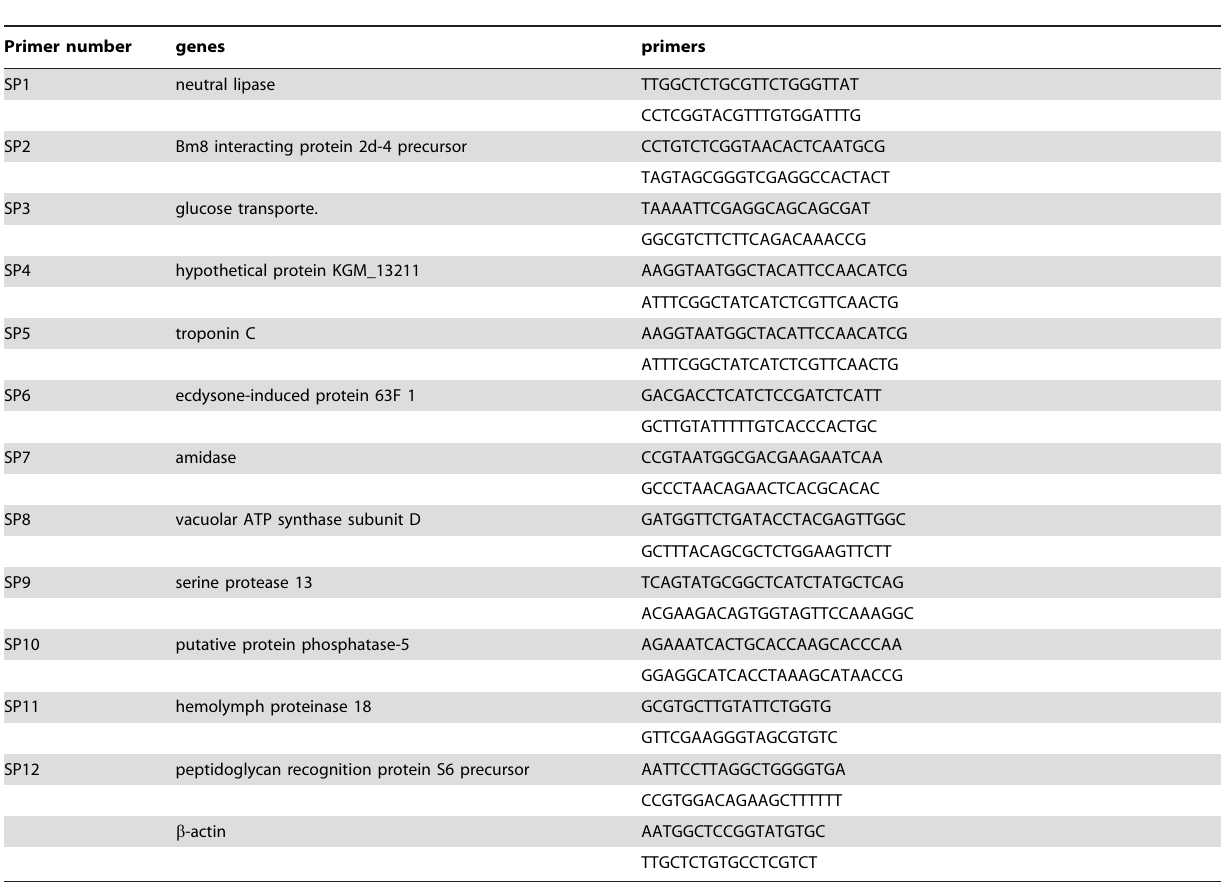
Table 4. Primers used in real-time qPCR for validation of